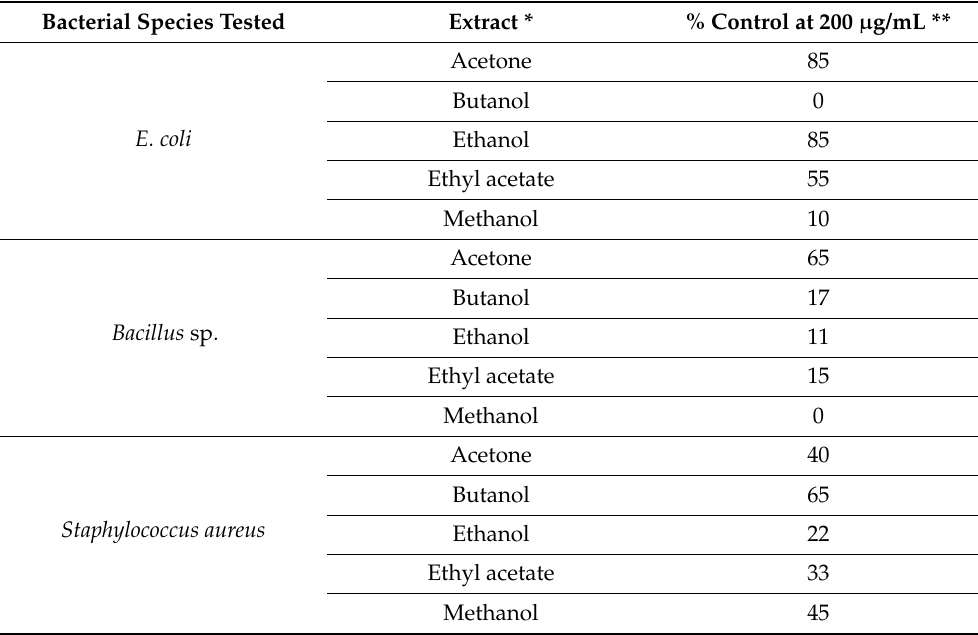
Table 2. The antibacterial activity of Acacia ehrenbergiana grown in Qatar.